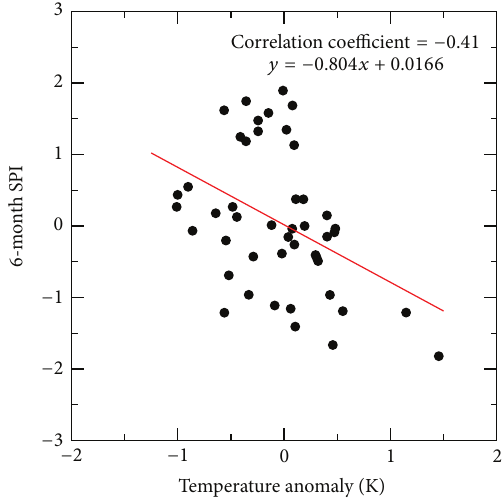
Figure7:ScatterplotofdomainaveragedLSTanomaliesat6:30p.m. and 6-month SPI over Congo rainforests during the wet season. The linear trend is determined by a least-square